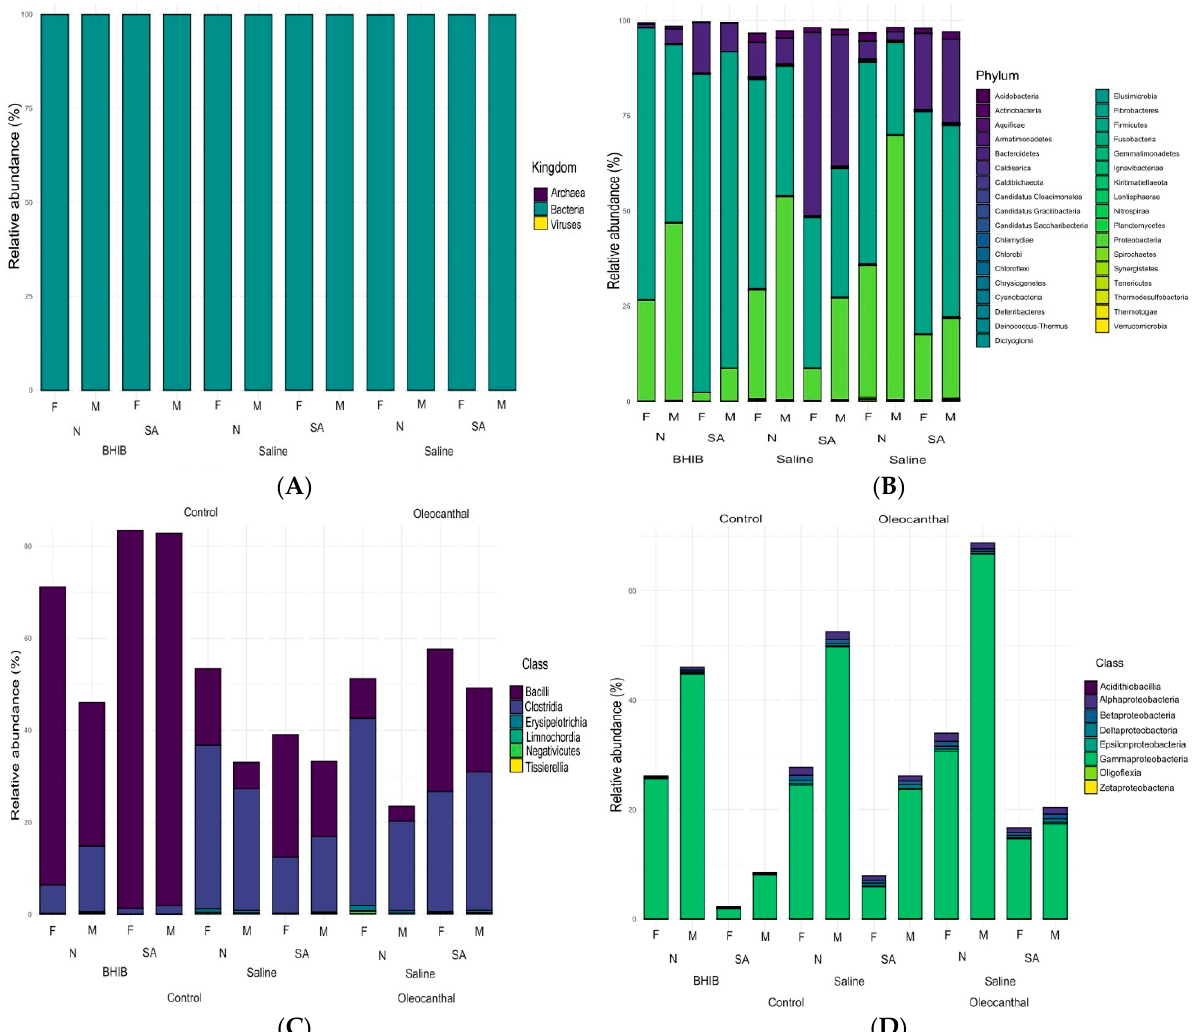
Figure 4. Comparison of the metagenomic profiles of taxonomic composition using shotgun sequencing of the GM. Individual vertical bars represent different samples of OC versus control in BHI and NS medium. ( A ) Composition at microbiota kingdom level; ( B ) composition at the bacterial phyla level; ( C ) bacterial classes profile for the highly prominent Firmicutes phylum; ( D ) bacterial classes profile for the highly prominent Proteobacteria phylum. N: nude mice; SA: Swiss albino mice.